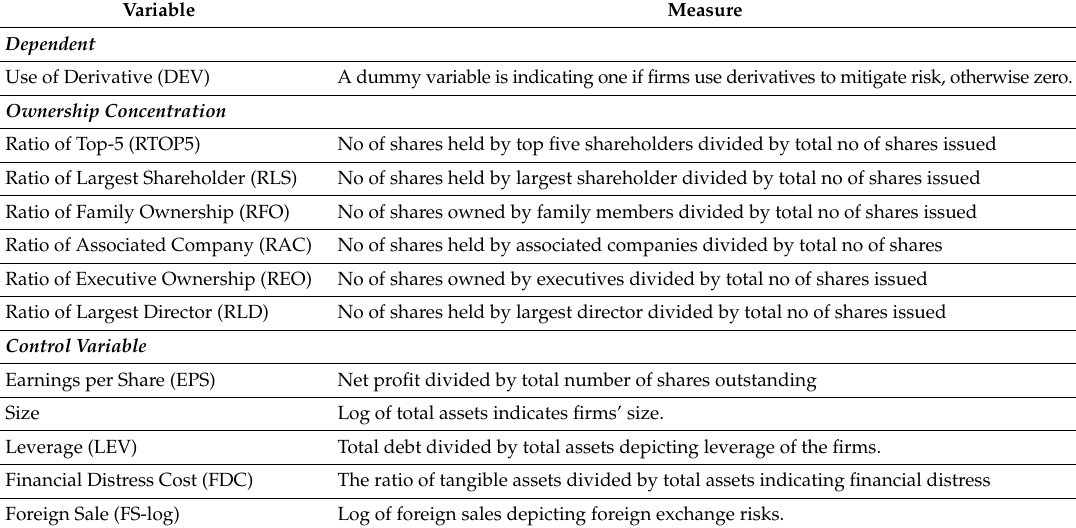
Table 1. Summary of Variables.